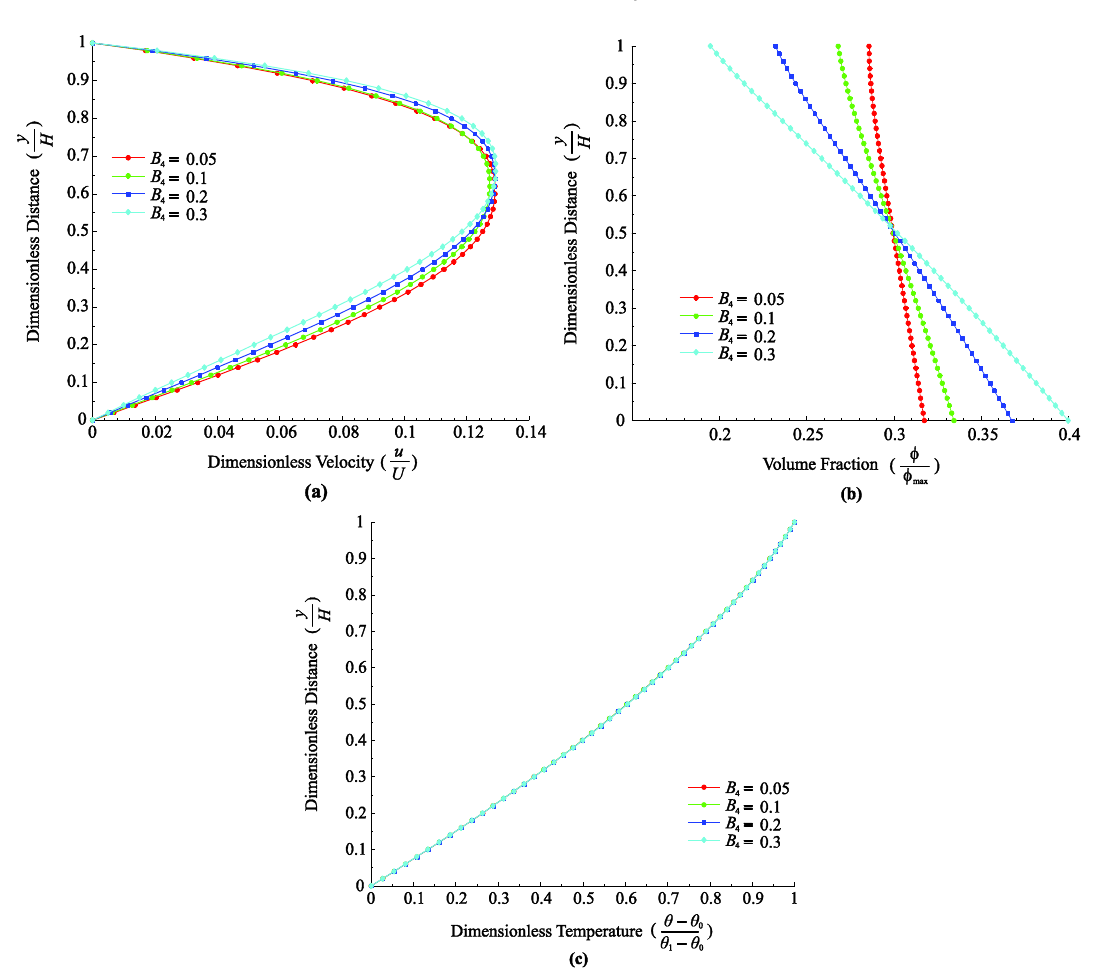
Figure 9. ( a ) Effect of 𝐵 volume fraction distribution. ( c ) Effect of 𝐵 𝑚 = −0.3, 𝑀 = 1, 𝐵 −0.02, 0.01, 2.3, −9, 11